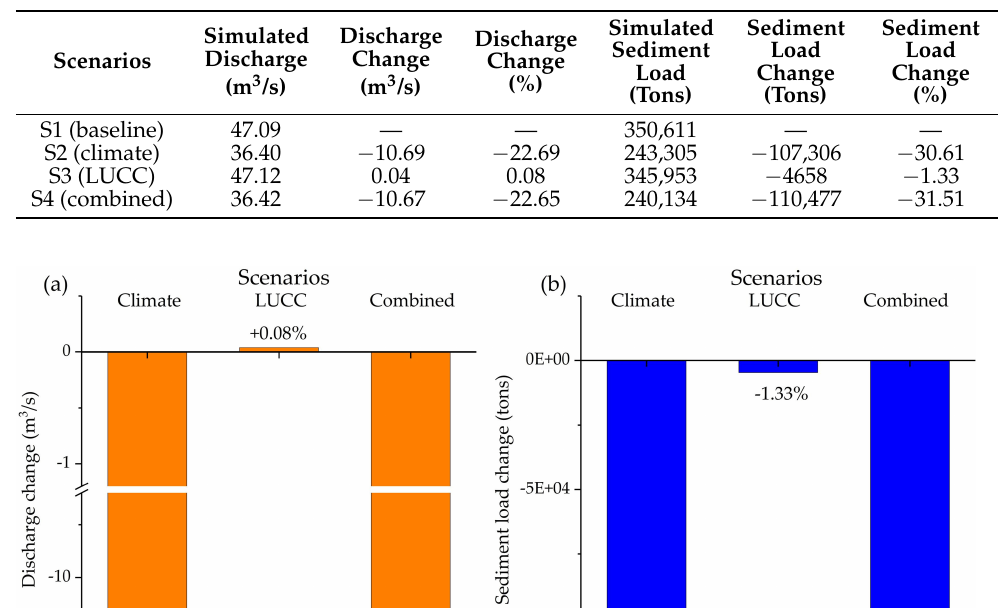
Table 7. Simulated annual discharge and sediment load under four setup scenarios.